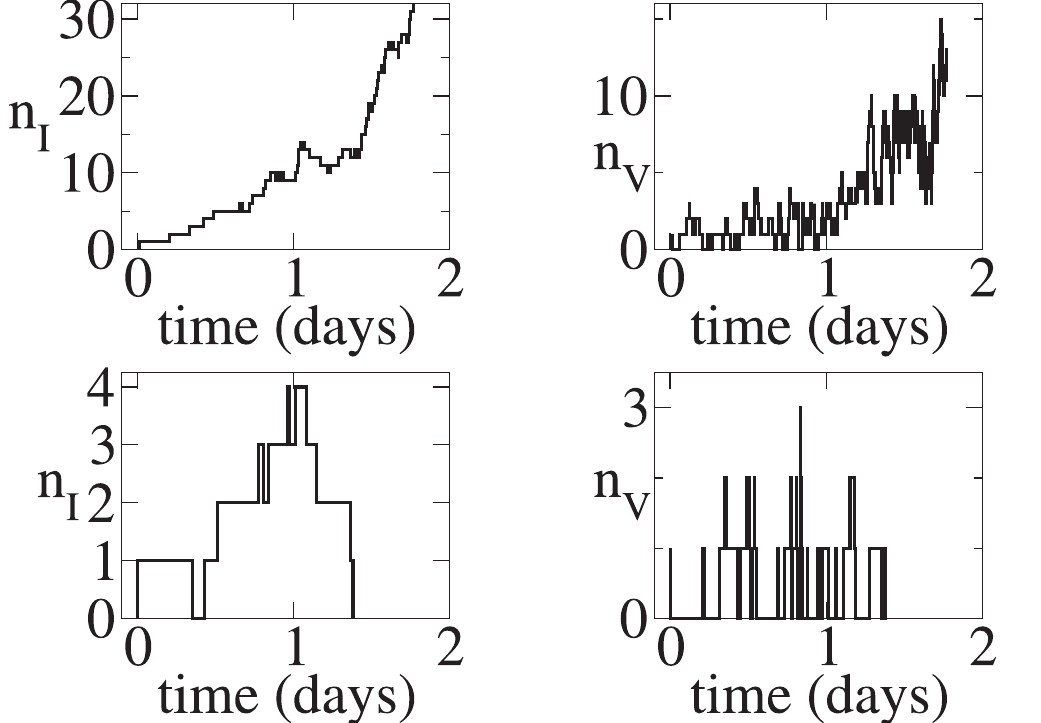
Figure 3. Continuous production model time series. Initial conditions: n V (0) ~ 1, n I (0) ~ 0 . Top left: n I versus t for a realization that leads to infection. Top right: n V versus t for the same realization. Bottom left: n I versus t for a realization that leads to extinction. Bottom right: n V versus t for the same realization. kT ~ 10 = day , c ~ 20 = day , and N ~ 10 .